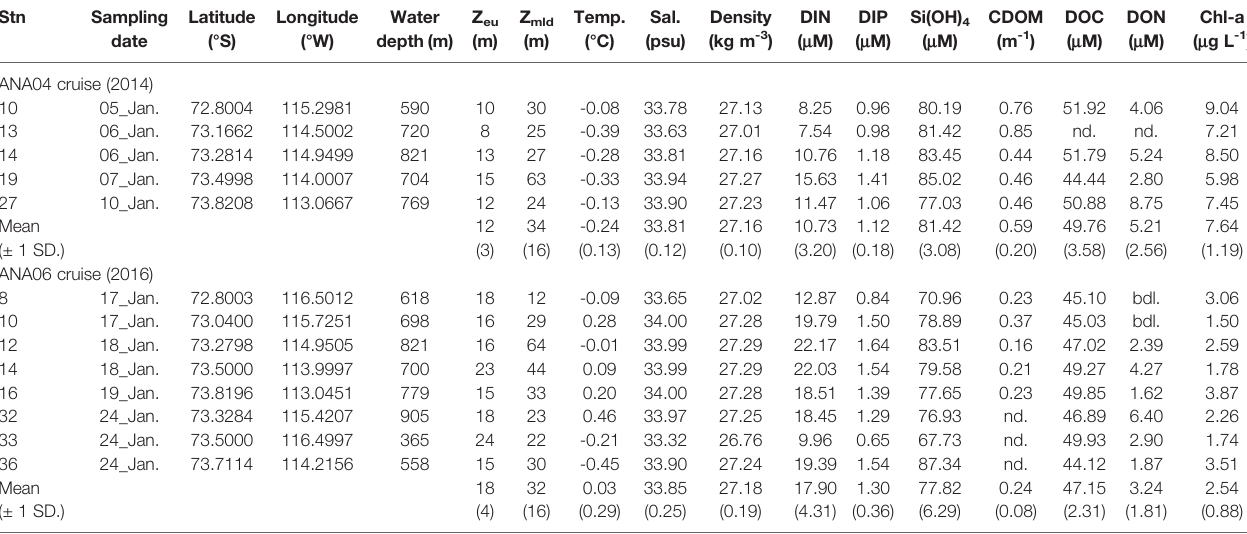
TABLE 1 | Oceanographic parameters in surface water from the Amundsen Sea polynya during ANA04 and ANA06. Stn Sampling